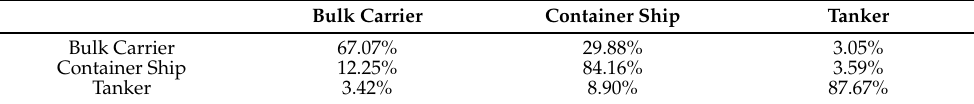
Table 7. The confusion matrix of SBNN in the three-categories SAR ship classification task.